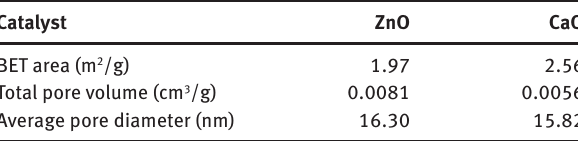
Table 3: BET surface area and porosity measurement.